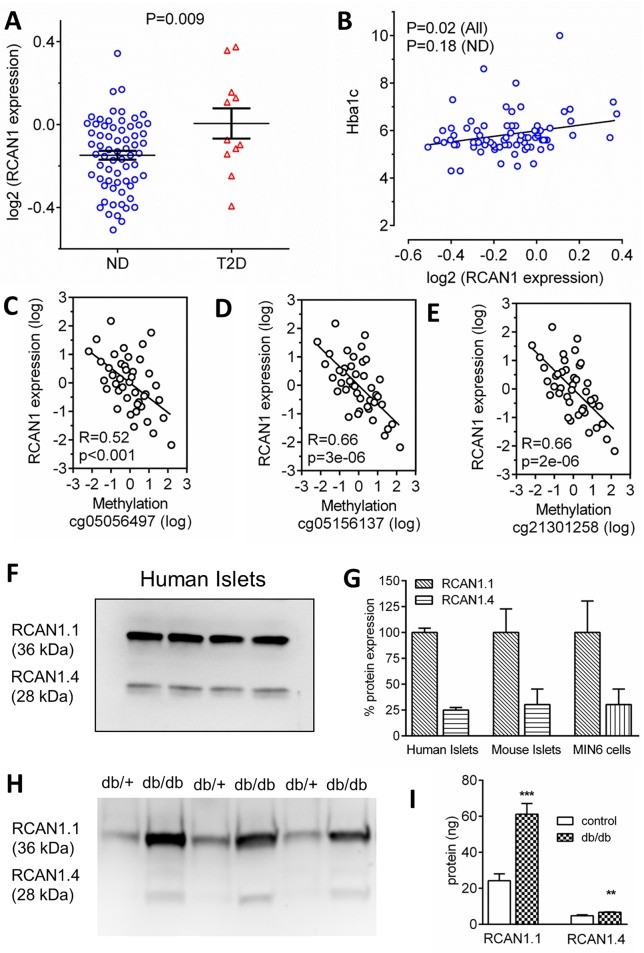
RCAN1 expression and methylation in human and mouse Type 2 diabetic islets.(A) RCAN1 gene expression in human non-diabetic (ND, n = 77, blue symbols) and type 2 diabetic islets (T2D, n = 12, red symbols). (B) RCAN1 expression vs donor HbA1c (n = 89). RCAN1 expression and methylation status at sites (C) cg05056497, (D) cg05156137 and (E) cg21301258 are strongly correlated. (F) RCAN1.1 and RCAN1.4 protein expression in human islets. (G) Quantification of RCAN1 islet protein expression in human islets (n = 3), mouse islets (n = 5) and mouse MIN6 β-cells (n = 3). (H) RCAN1.1 and RCAN1.4 protein expression in control (db/+) and db/db islets. (I) Quantification of (G) (n = 6 control, n = 5 db/db). **p < 0.01, ***p < 0.001.